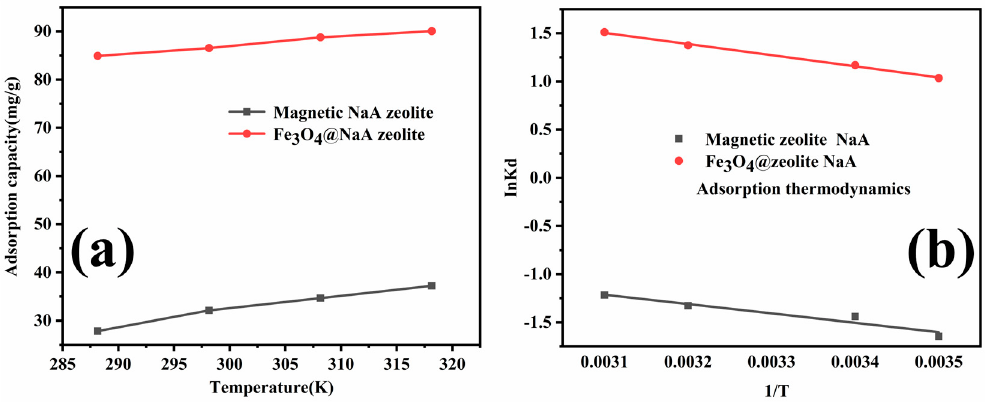
Figure 13. ( a ) Effect of temperature on adsorption of Cu 2+ by magnetic zeolite NaA and Fe 3 O 4 @zeolite Figure 13. ( a ) E ff ect of temperature on adsorption of Cu 2 + by magnetic zeolite NaA and Fe 3 O 4 @zeolite NaA ( b ). NaA ( b ). Thermodynamic parameters for Cu 2 + adsorption on magnetic zeolite NaA and Table 5. Thermodynamic parameters for Cu 2+ adsorption on magnetic zeolite NaA and Fe 3 O 4 @zeolite NaA.